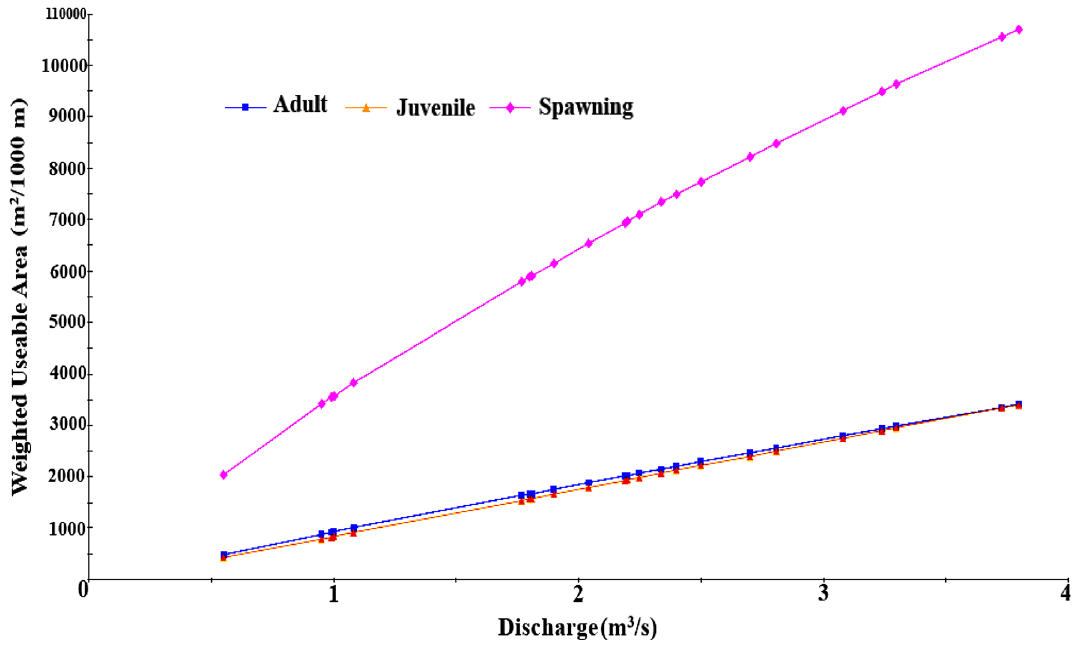
Fig. 8 Discharge-weighted useable area for Rutilus rutilus caspicus during three stages of juvenile fish, adult fish, and spawning in the Qarasu